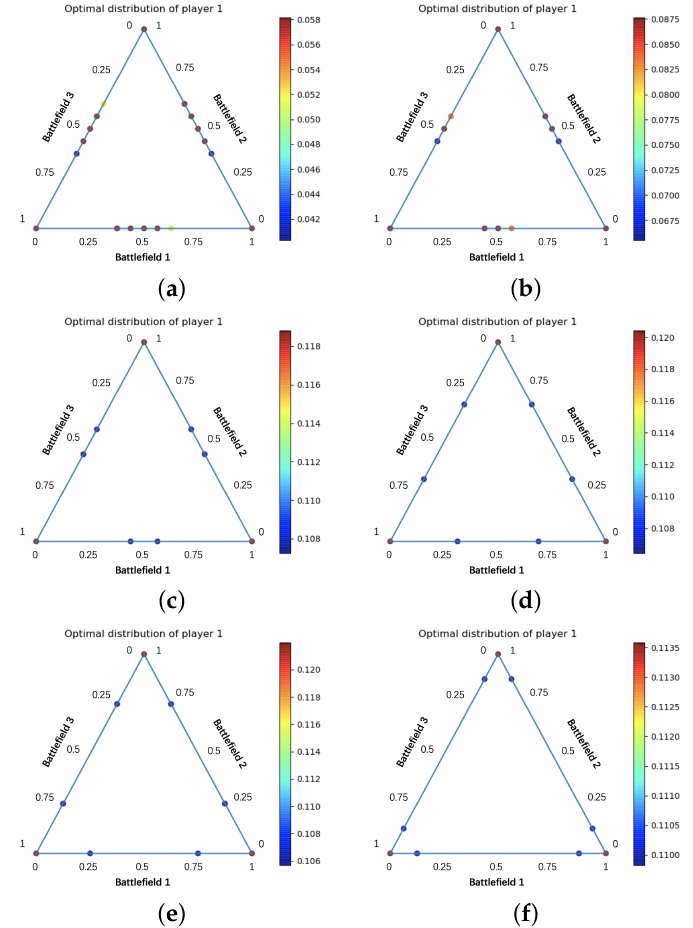
Figure 7. Optimal distribution of Player 1 corresponding to different M . ( a ) M = 40; ( b ) M = 50; ( c ) M = 60; ( d ) M = 70; ( e ) M = 80; ( f ) M =